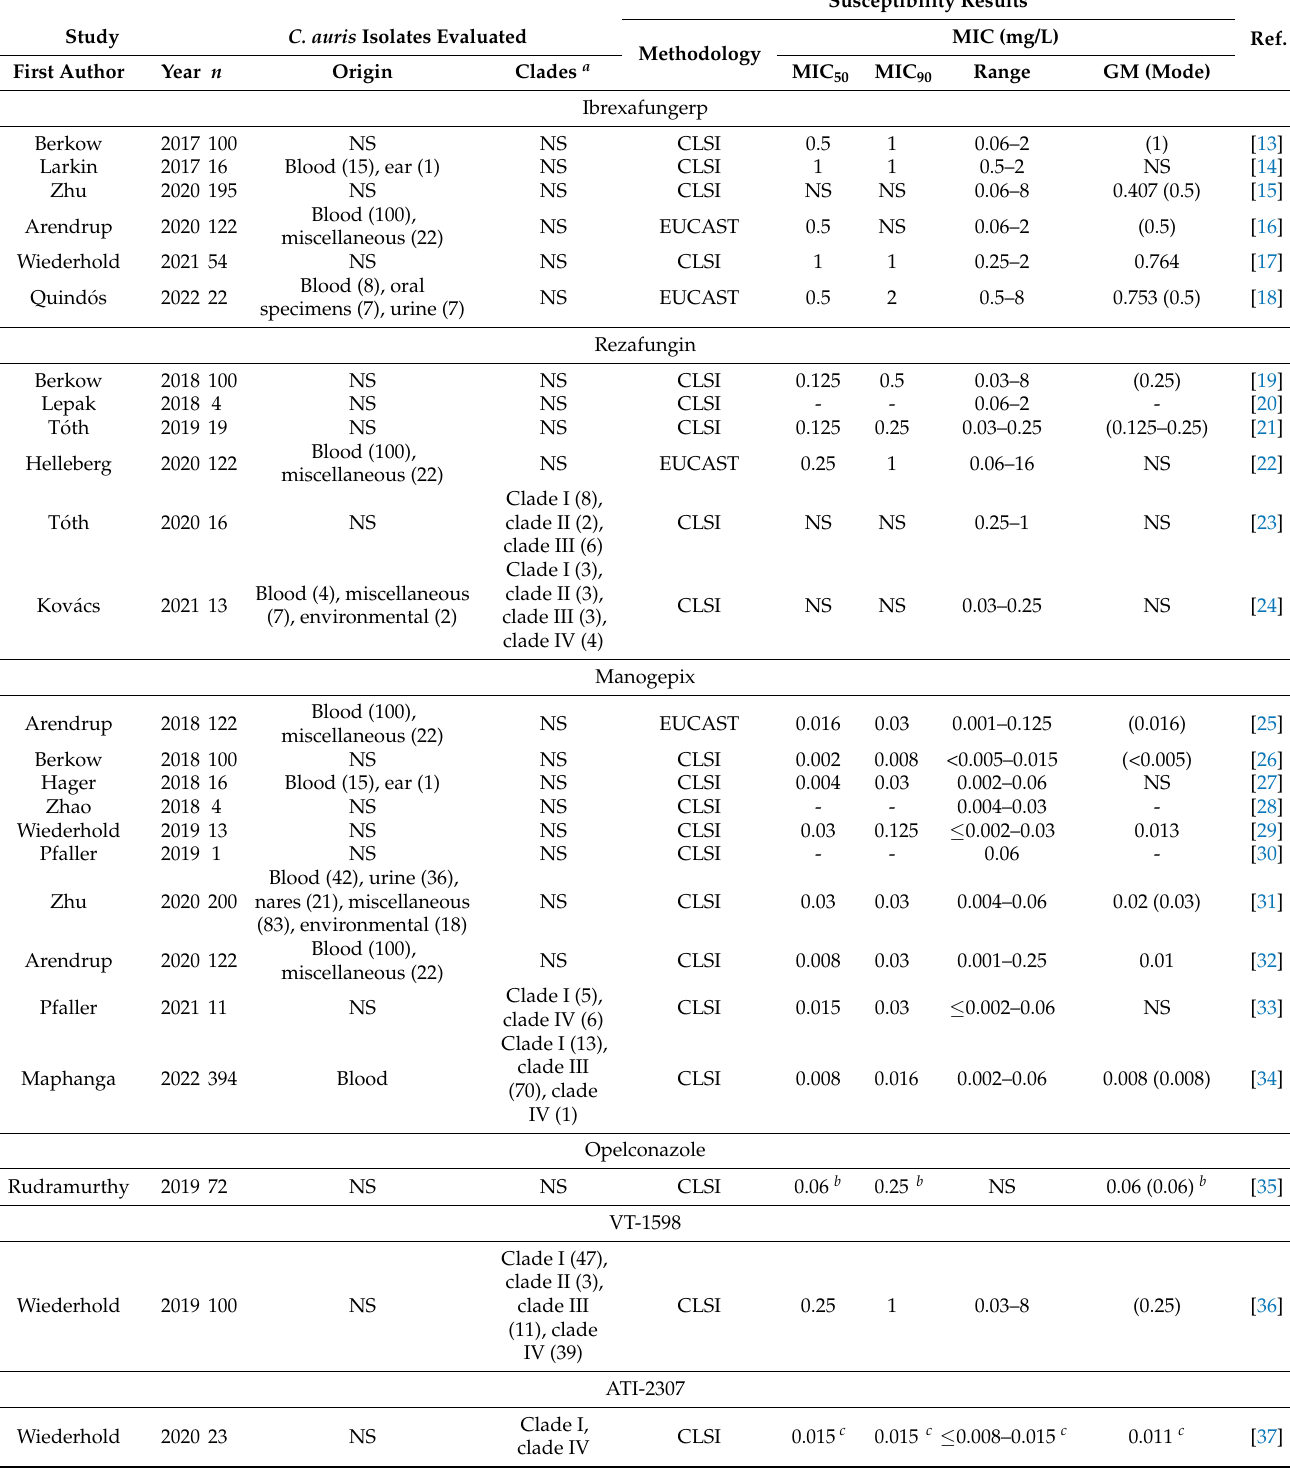
Table 1. Studies of in vitro antifungal susceptibility of investigational antifungals against Candida auris